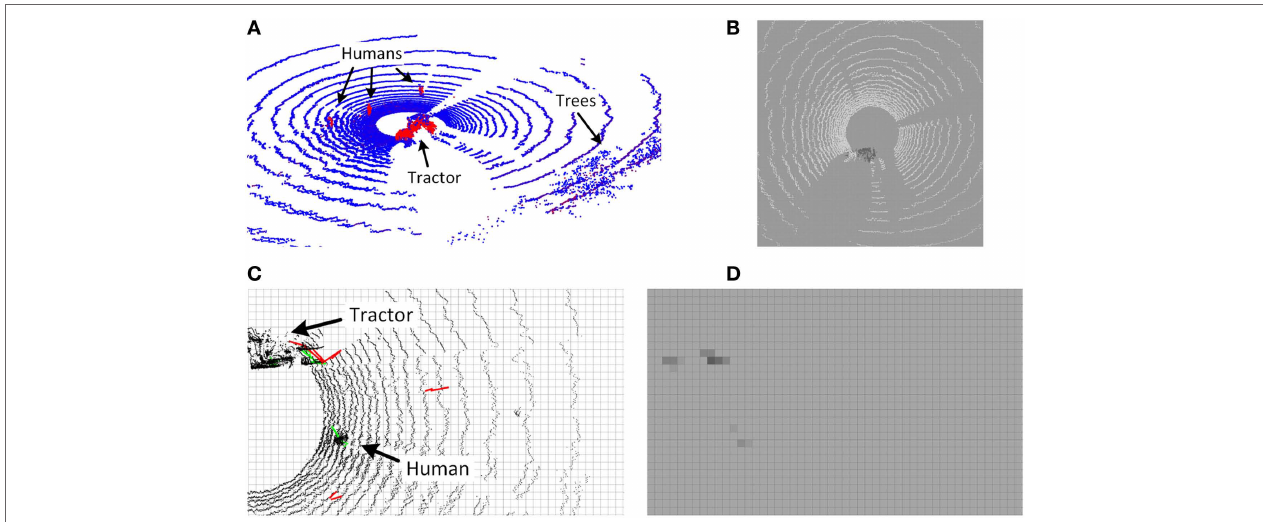
FIGURE 6 | Lidar and radar detections and OGMs. (A) Point cloud with pseudo-colored probability estimates of the object class. Blue and red denote low and high probabilities, respectively. (B) Resulting lidar OGM for the object class illustrating low (bright) and high (dark) probabilities. (C) Radar detection example with confirmed (green) and unconfirmed (red) radar tracks overlaid on point cloud. (D) Resulting radar